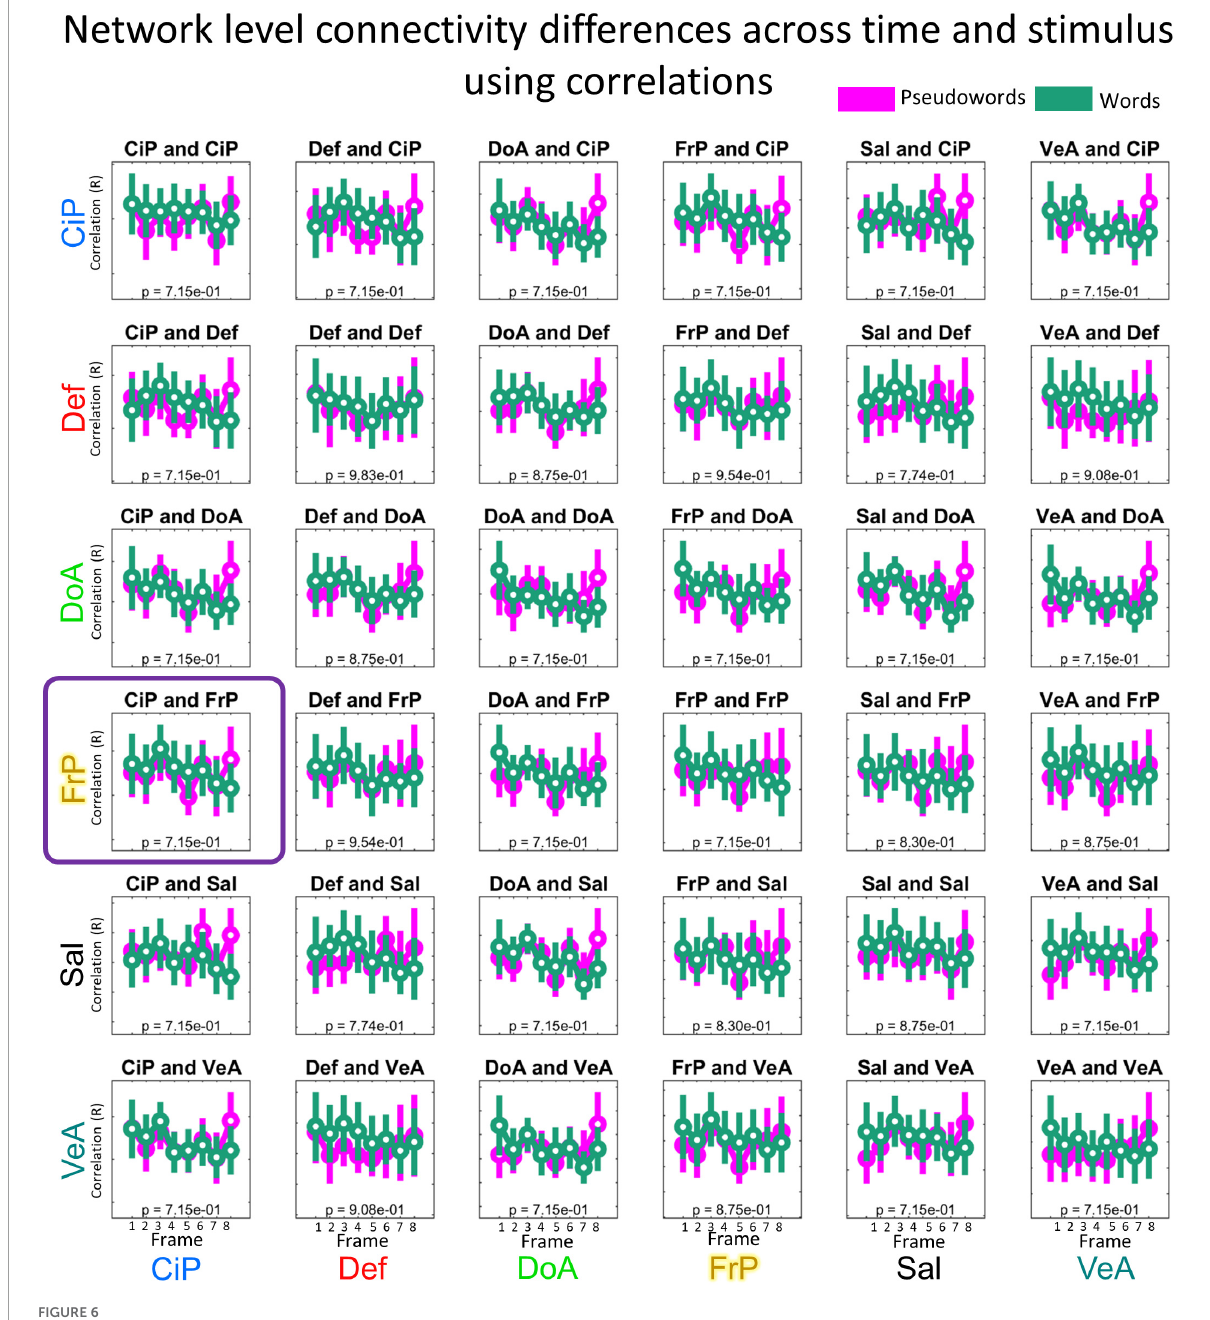
FIGURE6 Distribution of mean connectivity values calculated using Pearson correlations per functional network pair and condition. Same description as in Figure 4